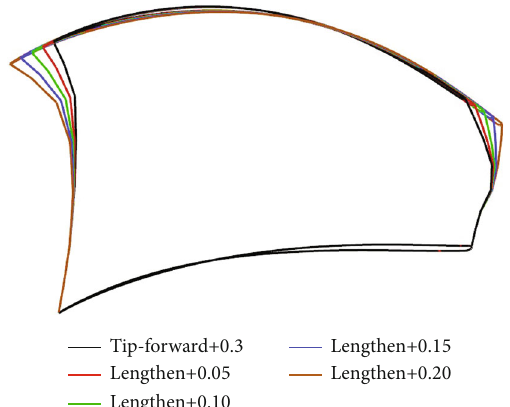
Figure 26: Shapes of the fi ve blades.